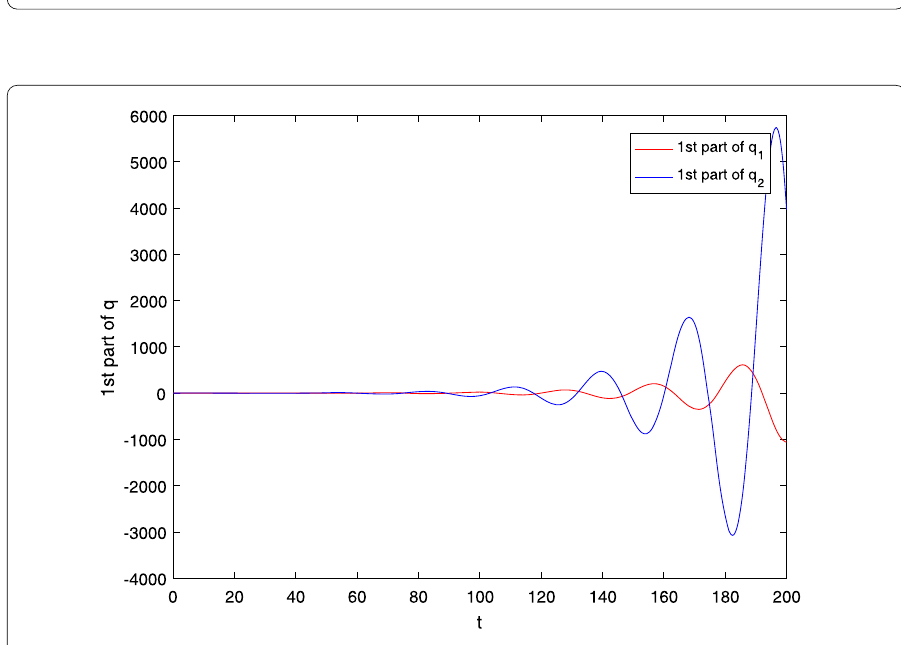
Figure 7 The first part of the state trajectories for system (1) with δ =